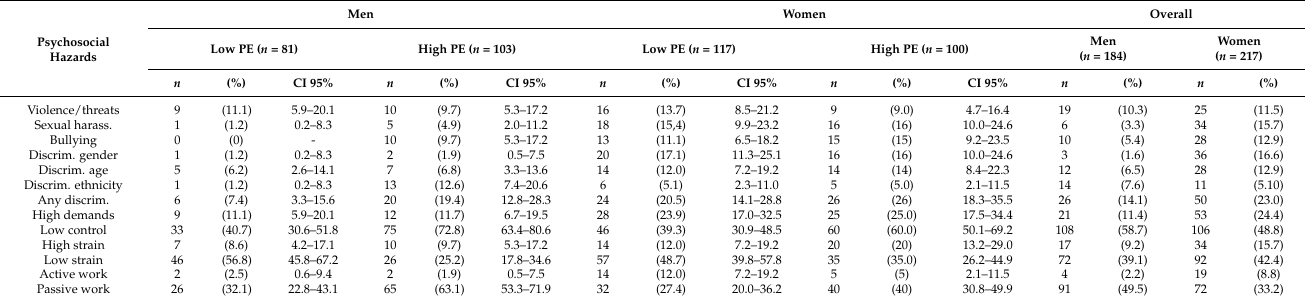
Table A1. Prevalence of reporting psychosocial hazards stratified by gender and level of PE. ( n = 401).